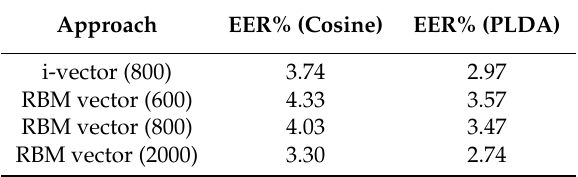
Figure 5. Speaker segmentation results in terms of False Alarm Rate (FAR) and Miss Detection Rate (MDR) in %. Results are obtained using different Window sizes ( d ) and a constant shift i.e., ∆ = 0.25 s. A collar of ± 0.25 s is accepted around a speaker change point. Table 2. Comparison of speaker tracking results for the proposed RBM vectors with 800 dimensional i-vectors, in terms of EER in %. The lengths of RBM vectors and i-vectors are given in parenthesis. Column 2 and 3 represents EER in % for cosine and PLDA Scoring